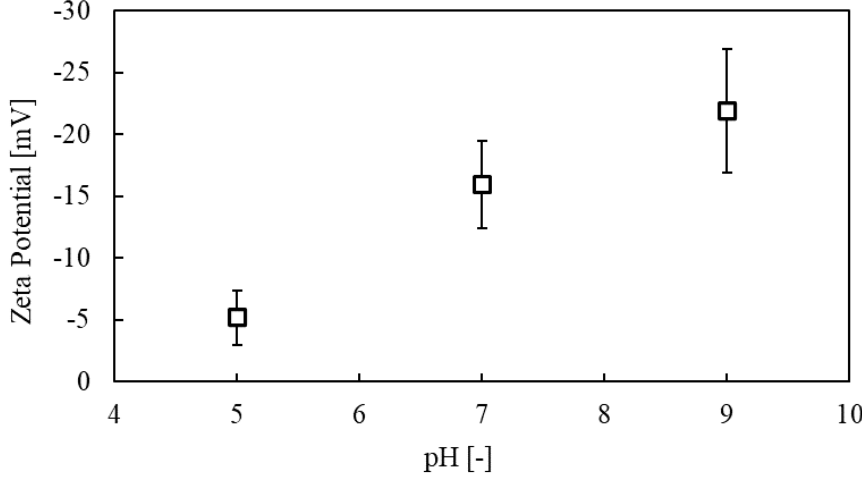
Figure 6. Zeta potential versus pH in solutions with UFBs bubbled for 30 min (error bars indicate standard error).